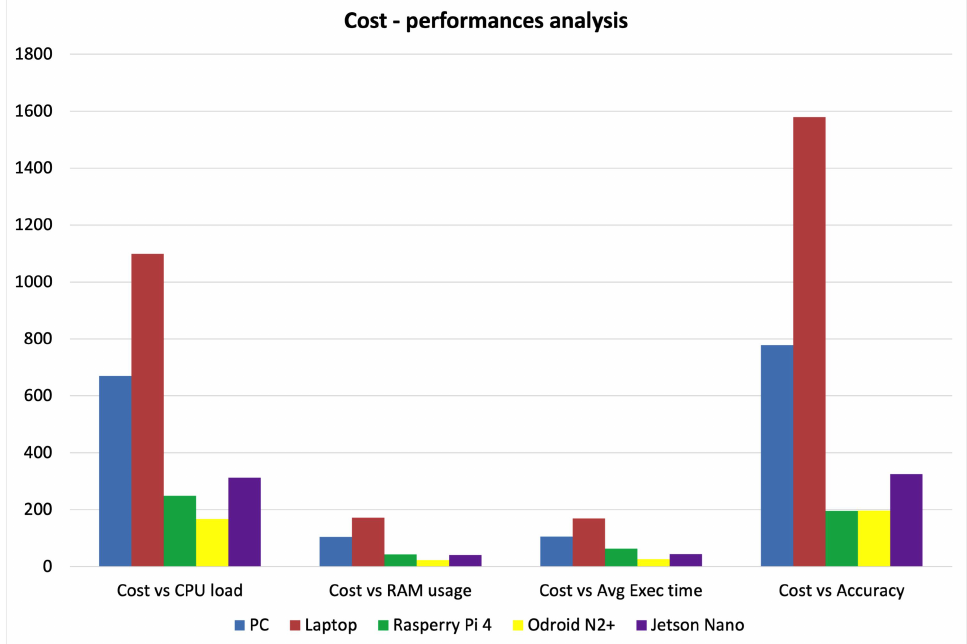
Figure 9. Cost-performance analysis on the considered elaboration